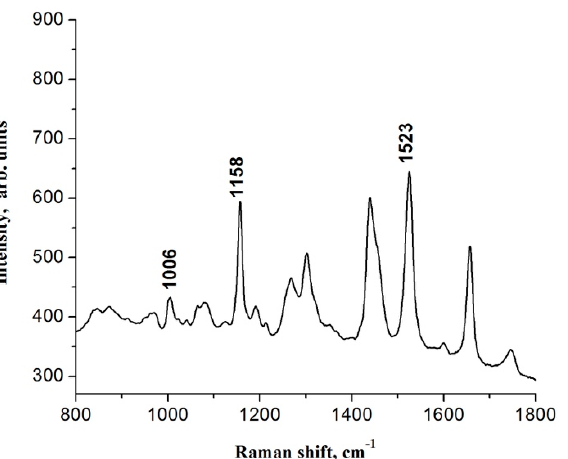
Figure 2. Region of the Raman spectrum of an oil sample from Sondias mombin L. where Raman frequencies are located at 1006, 1158 and 1523 cm − 1 , which are associated with carotenoids compounds.